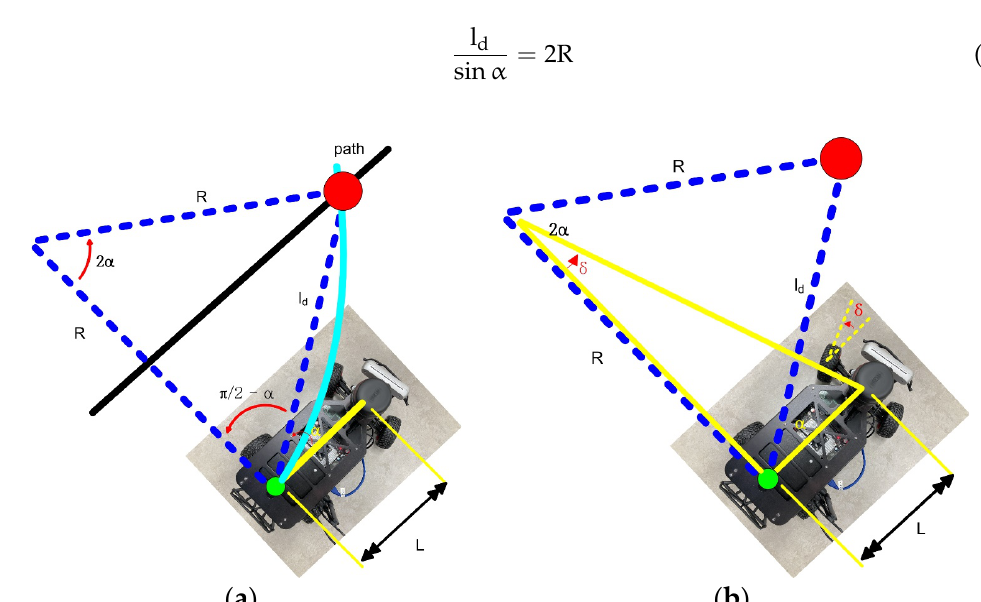
Figure 2. Pure Pursuit path tracking control. ( a ) Geometry of Pure Pursuit for look ahead distance. ( b ) Geometry of Pure Pursuit for δ. The red circle is the point the robot want to track, and the blue dashed line connecting the red circle and the center of the rear wheel of the robot is the look ahead distance (l d ). The robot steers and turns to move to the tracking point, and the arc of the circle created at this time is the arc marked in light blue. The radius of the circle made using the light blue arc is R. L is the length connecting the center of the front and rear wheels of the robot.